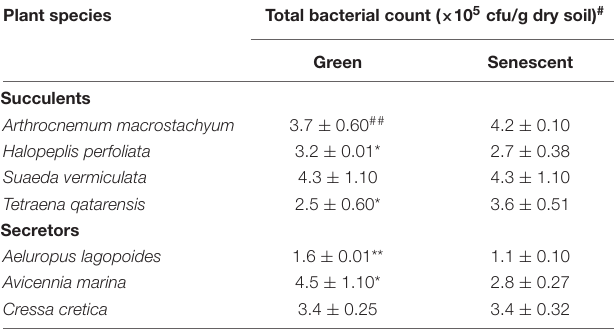
TABLE 2 | Total bacteria count on the phyllosphere of green and senescent parts of some halophyte plants in the coastal salt marshes at Al-Dhakhira region-Qatar (Fahmy and Al-Thani,